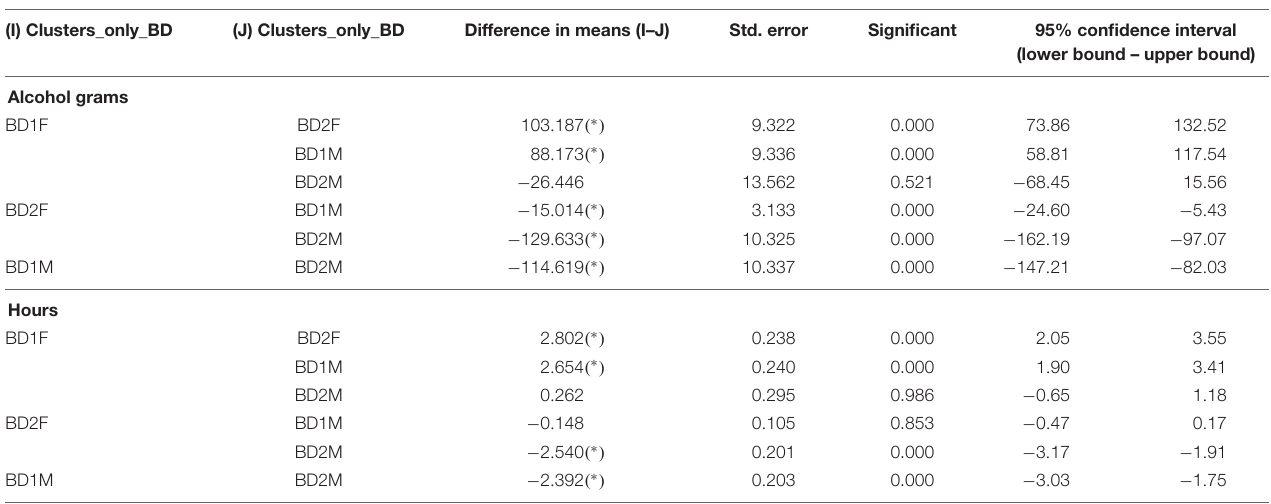
TABLE 3 | A posteriori Games-Howell